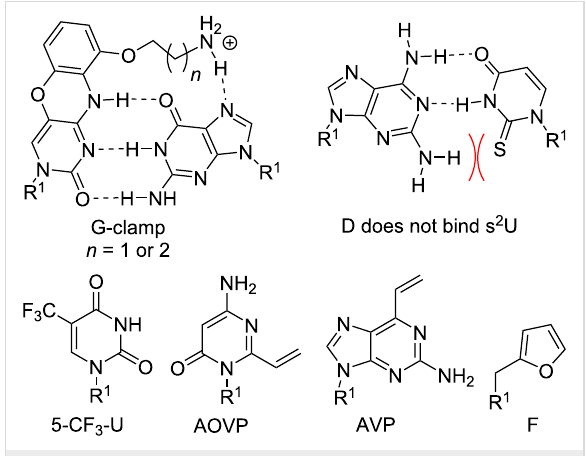
Figure 8: Modified nucleobases to modulate Watson–Crick base pairing and chemically reactive crosslinking PNA nucleobases. R 1 denotes DNA, RNA, or PNA